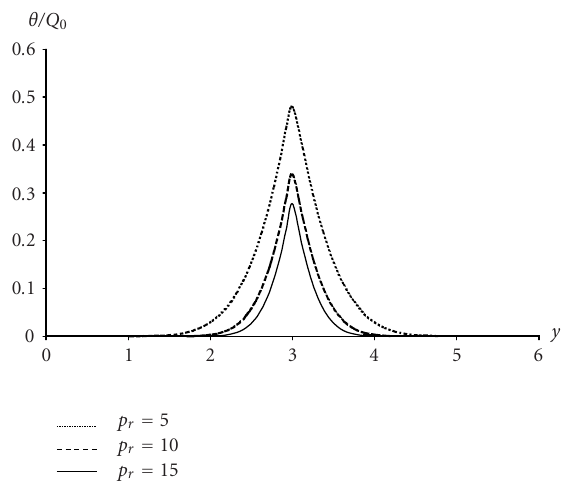
Figure 7.7. The temperature distribution for di ff erent values of p for the semispace problem.